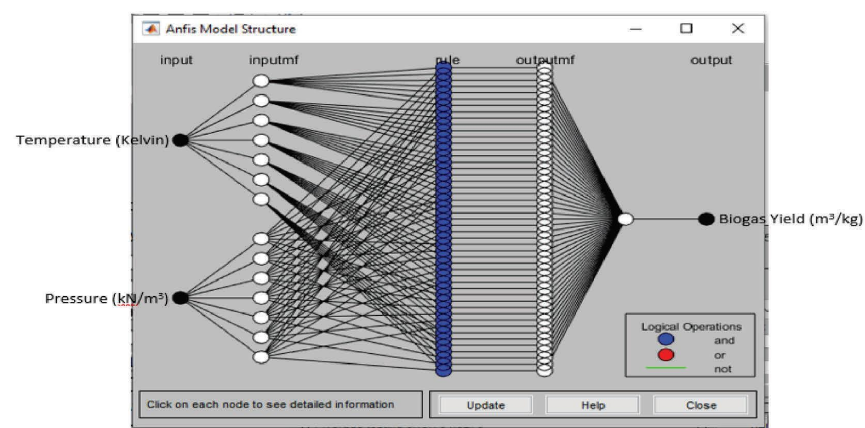
Figure 6: Generated ANFIS model structure for prediction.